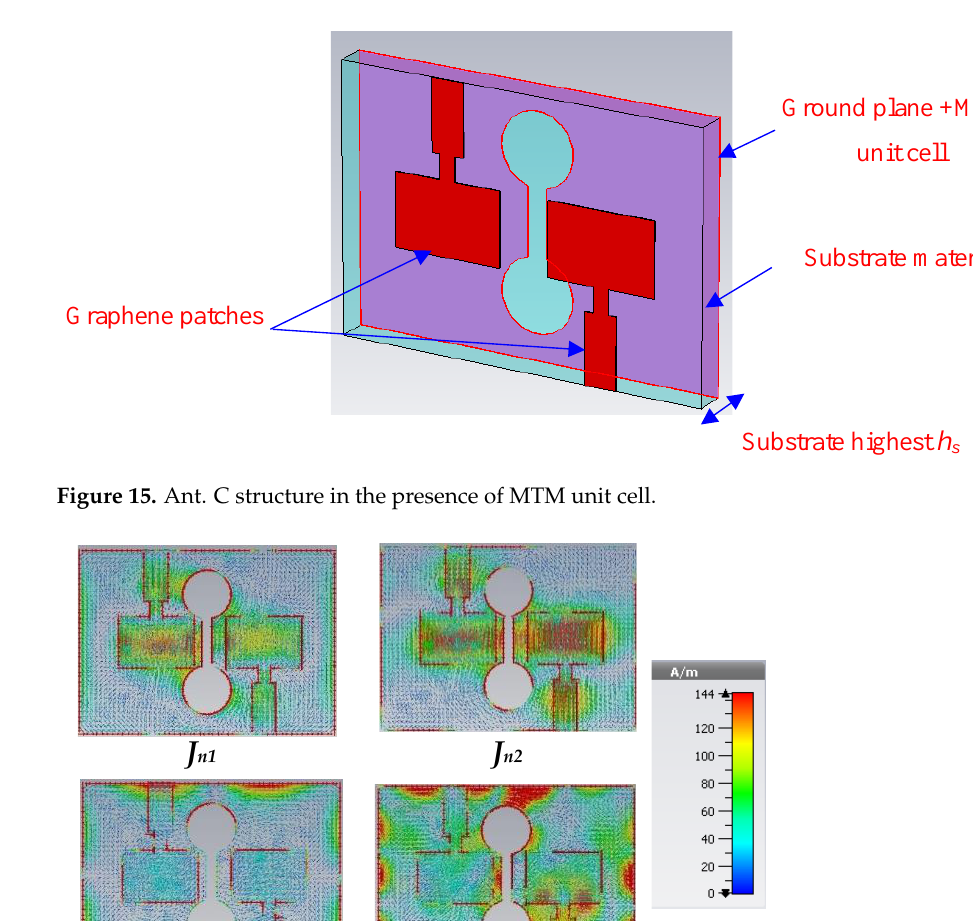
Figure 17. Model significant of Ant. C with the MTM unit cell .